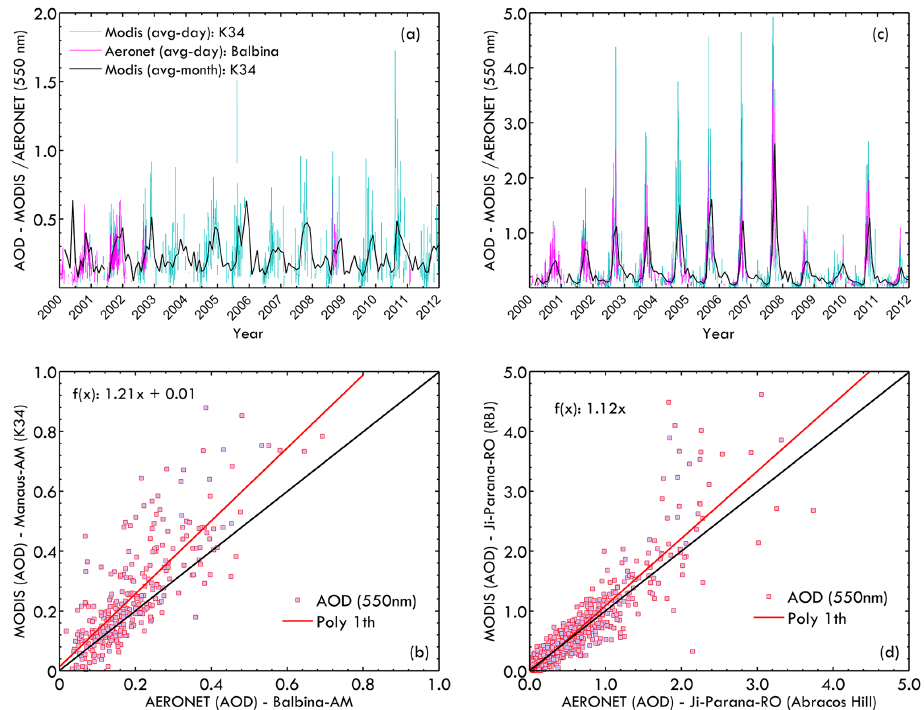
Figure 5. Time series of AOD (at 550nm) from 2000 to 2012 estimated by MODIS and measured by the AERONET sun photometer at 550nm at the K34 site (a) and at the RBJ site (c) . Panels (b) and (d) show regressions of the estimation of AOD by MODIS at K34 (b) and at RBJ (d) . The red lines represent the linear fits at both sites, with R 2 equal 0.64 (K34) and 0.84 (RBJ). The AOD values (AERONET) at 550nm were calculated through Ångström α ∼ 1.01 at the Balbina-AM site (b) and α ∼ 1.48 at the Abracos Hill (d) site. The differences between linear fit found between the estimates made by the MODIS (550nm) and by sun photometer AERONET (500nm) are less than ∼ 5% (results not